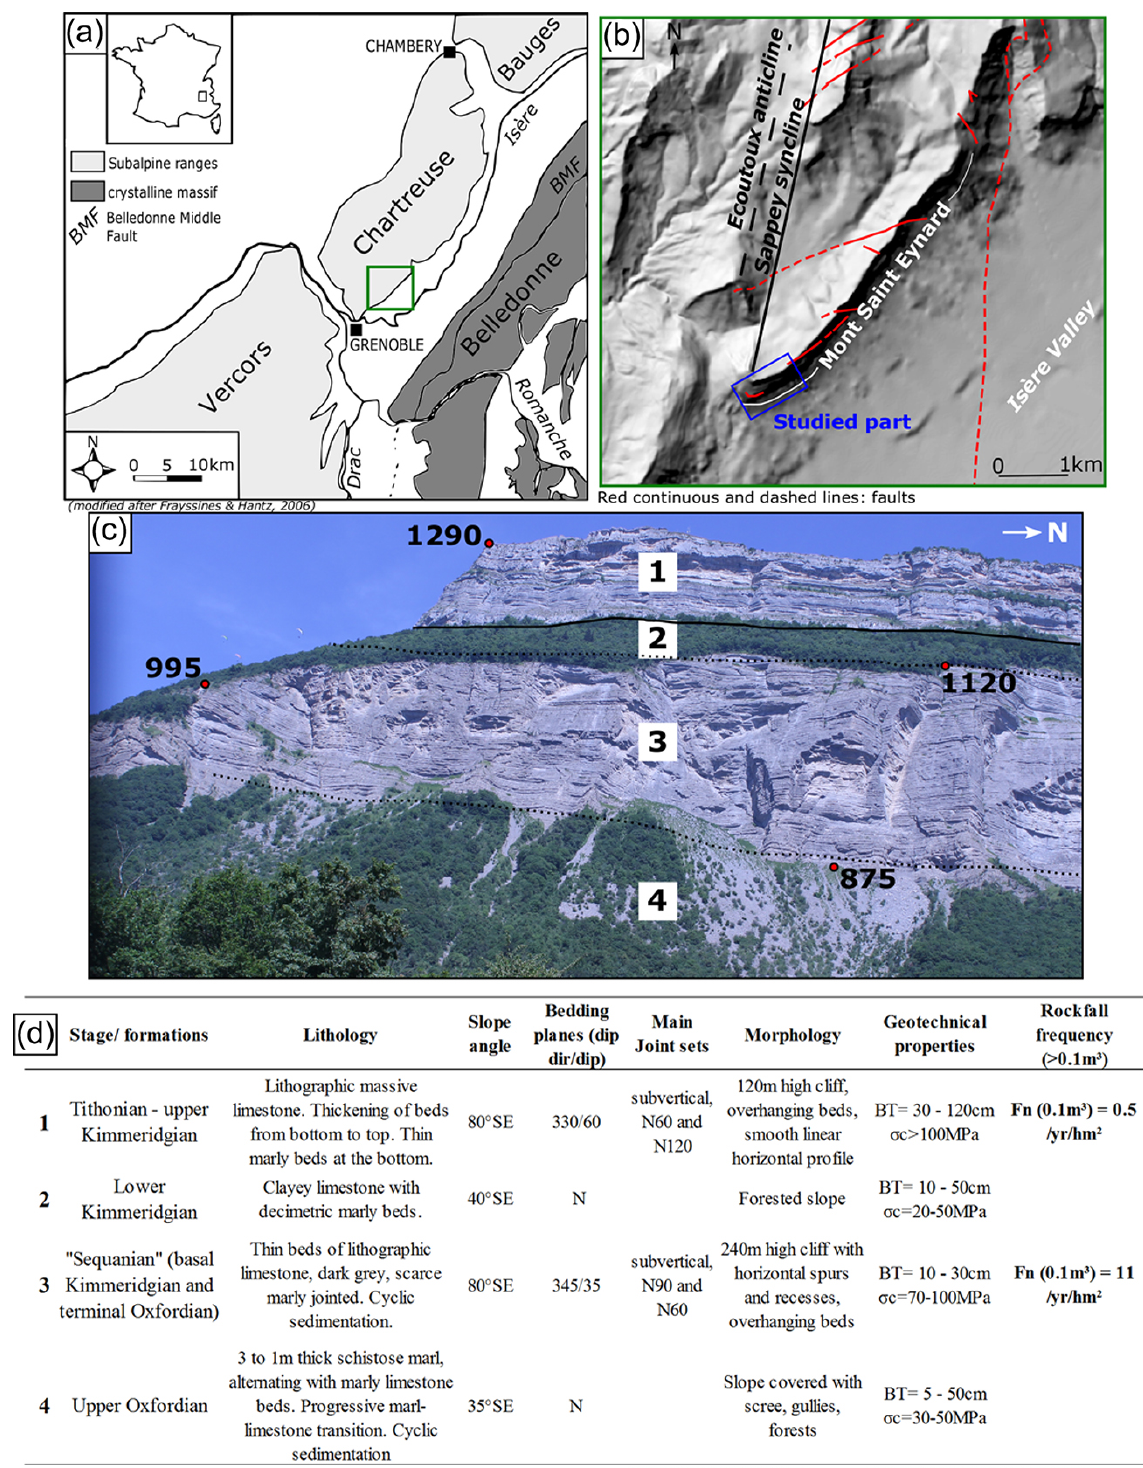
Figure 1. (a) Simplified geological map of the subalpine ranges. (b) DEM of the studied zone, with structural features. (c) Photograph of the studied part of the Mont Saint Eynard. Dashed lines: supposed geological limit; continuous line: confirmed geological limit. (d) Geological and geotechnical information (Chardon, 1987; MELTT,